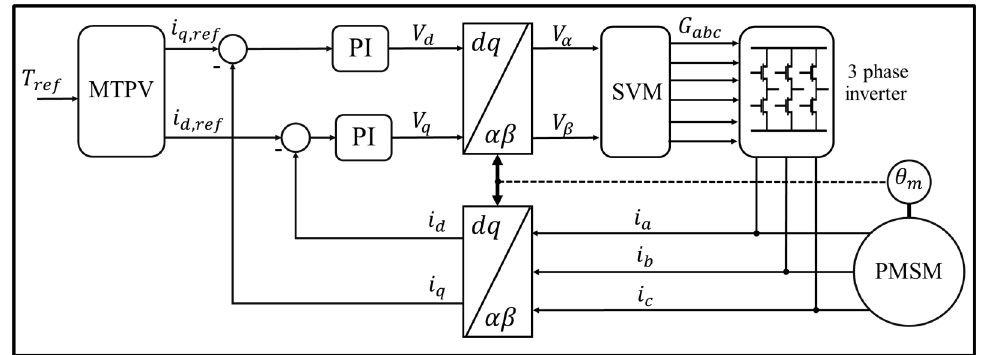
Figure 3. Field-oriented current control